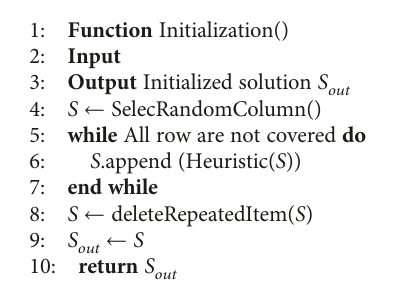
Algorithm 2: Initial solution